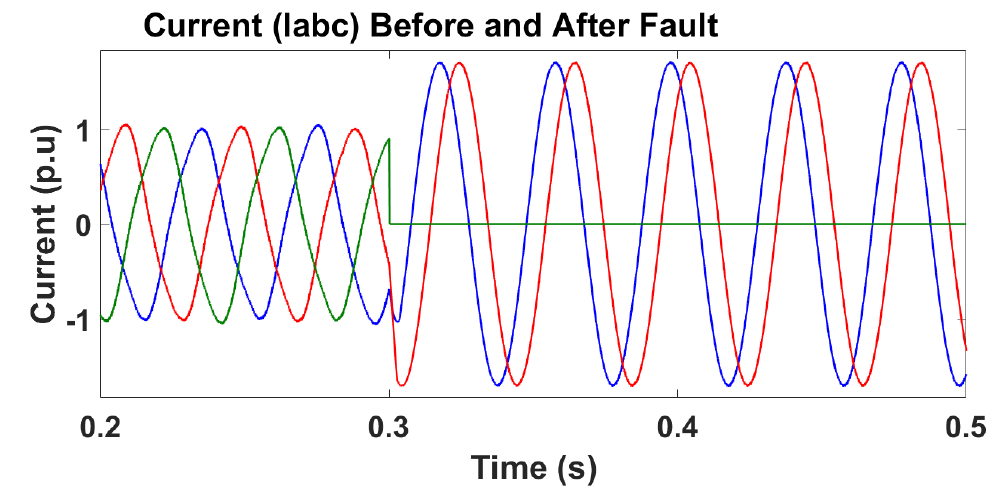
Figure 9. Current flowing from inverter to grid before and after fault with proposed control. Table 1. Values of power ( P 3 ϕ ) and inverter voltages ( v in 1 ) and ( v in 2 ) for different values of φ .